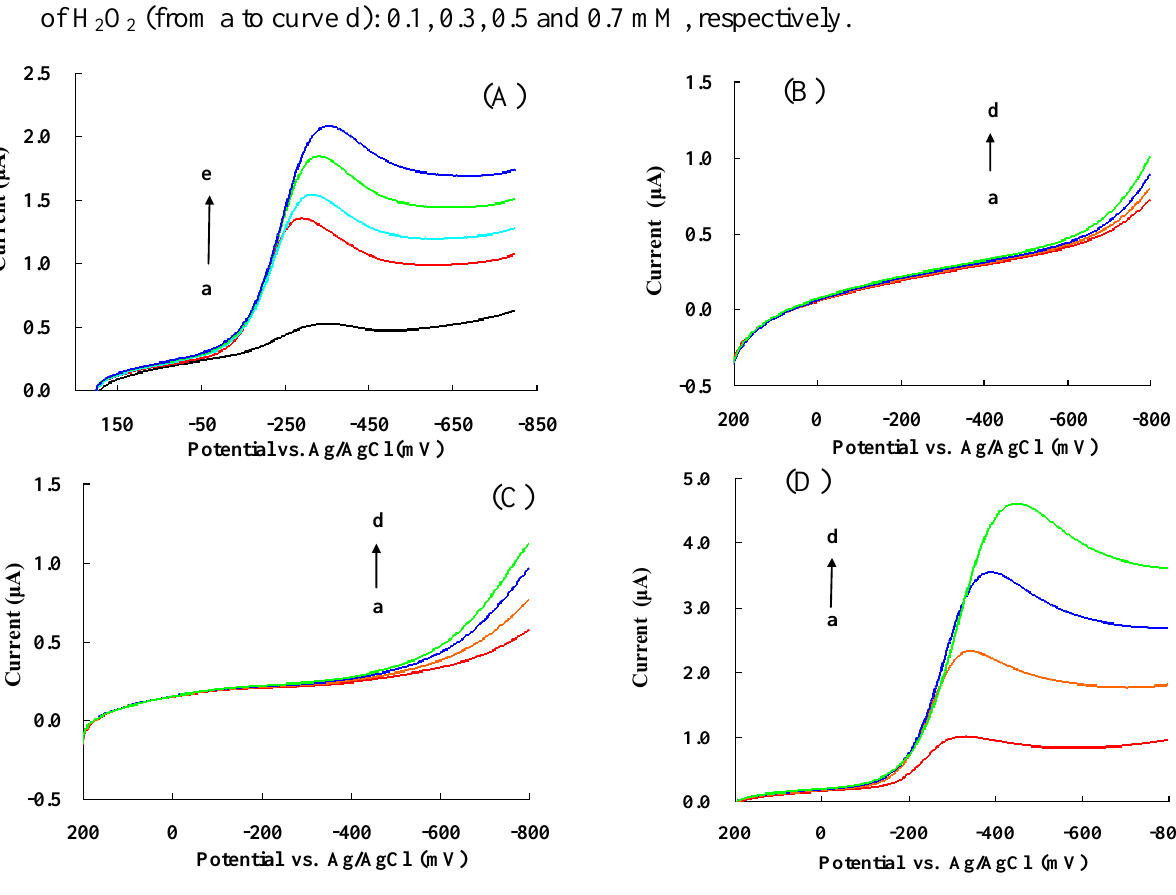
O (from curve a to curve e): 0, 0.1, 0.13, 0.16, 2 2